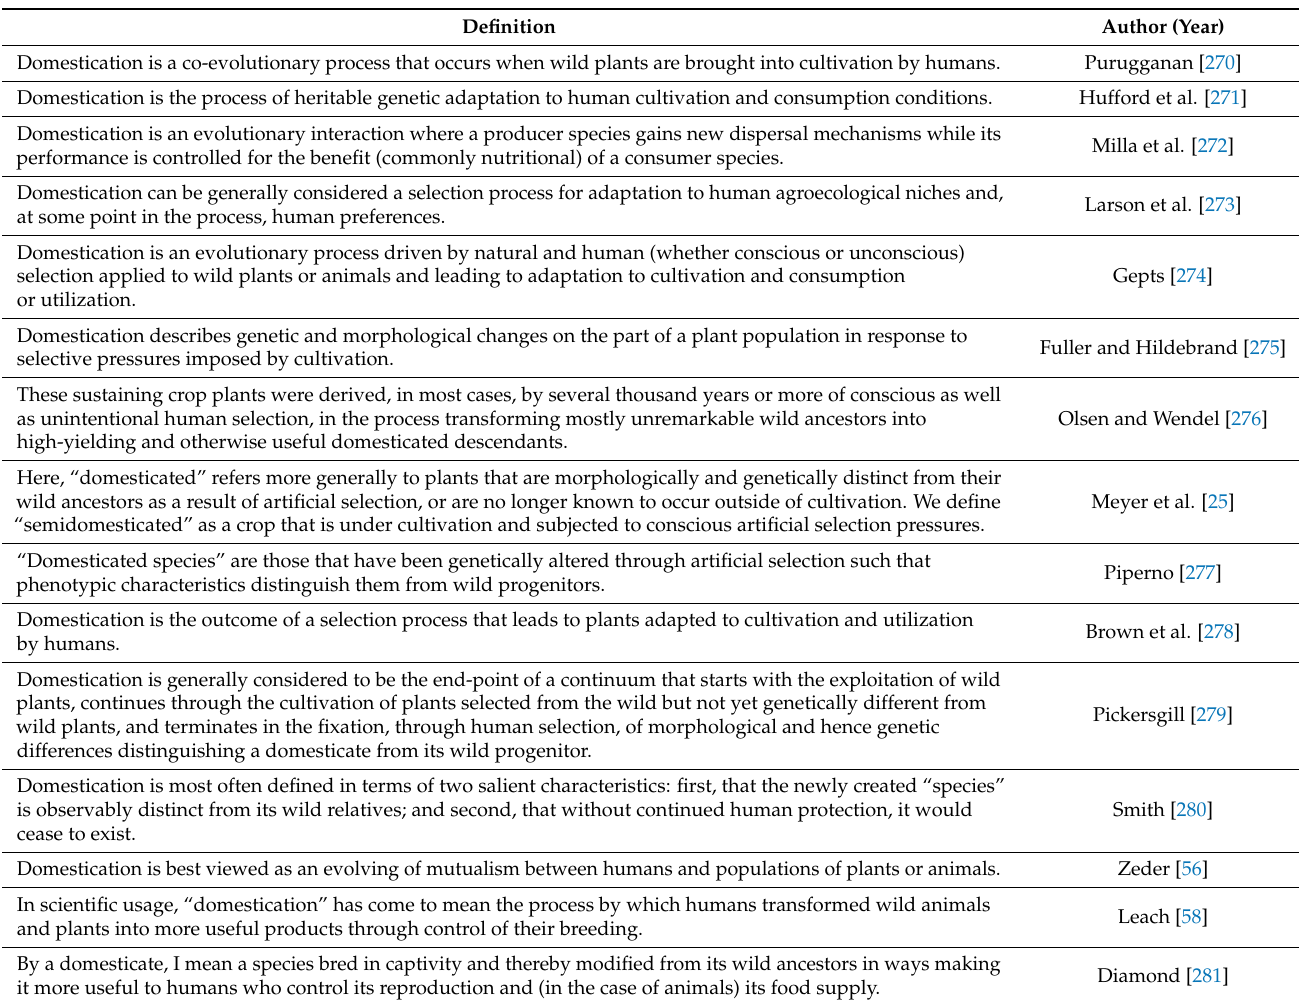
Table A1. A non-exhaustive list of definitions of domestication by archaeologists, geneticists and other students of domestication since the turn of the